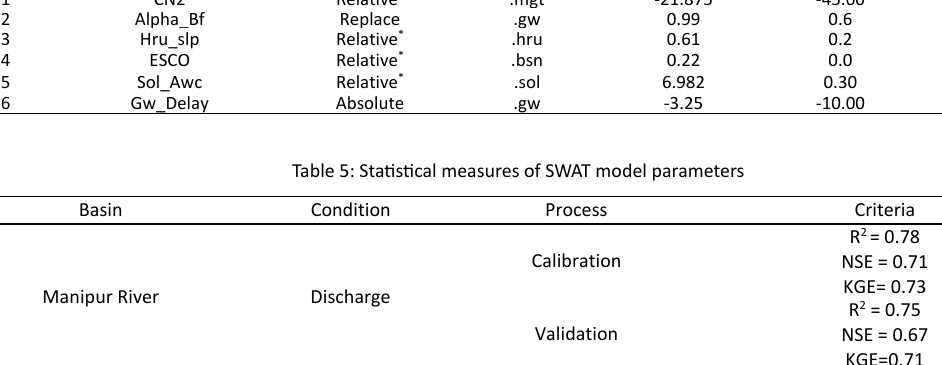
Table 4: Calibrated parameter values with their ranges Table4: Calibrated parameter values with their ranges S.No.